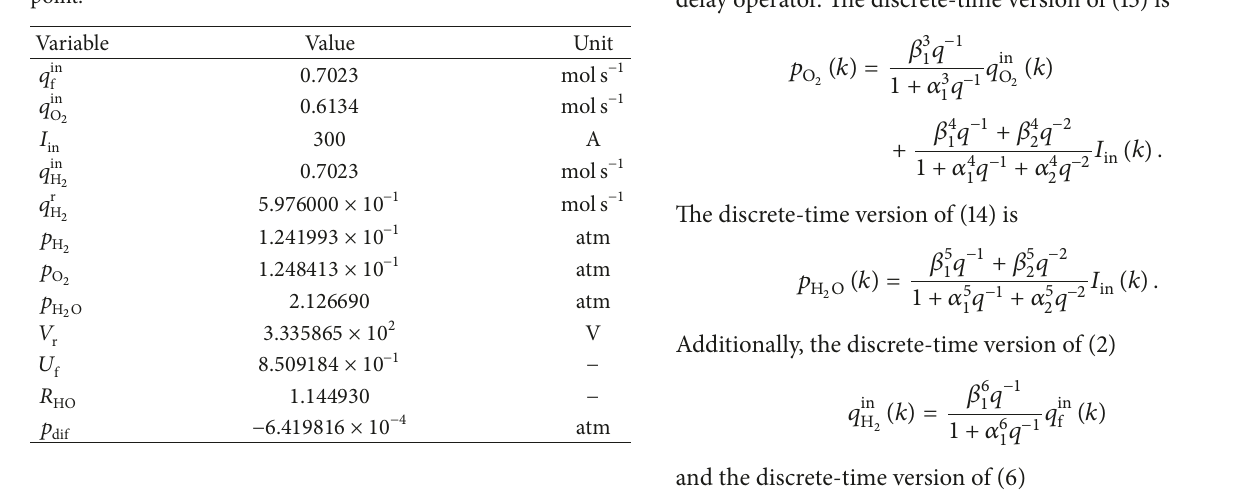
Table 2: The values of process variables for the initial operating